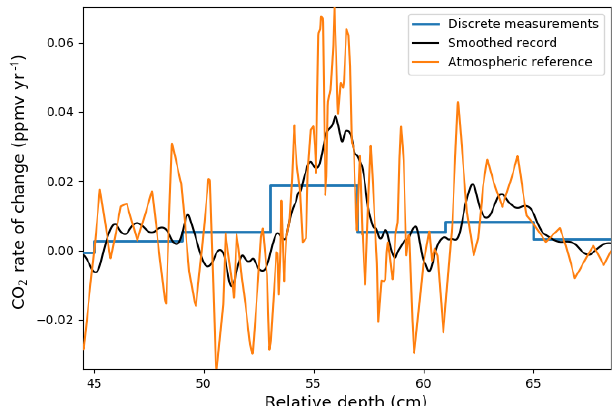
Figure 13. Impact of gas trapping processes and measurements on the CO 2 rate of change. The rate of change in the atmosphere is displayed in orange, while the rate change recorded in the ice is in black, and the measured one is in blue. The depth scale is the same relative depth scale as in Fig.